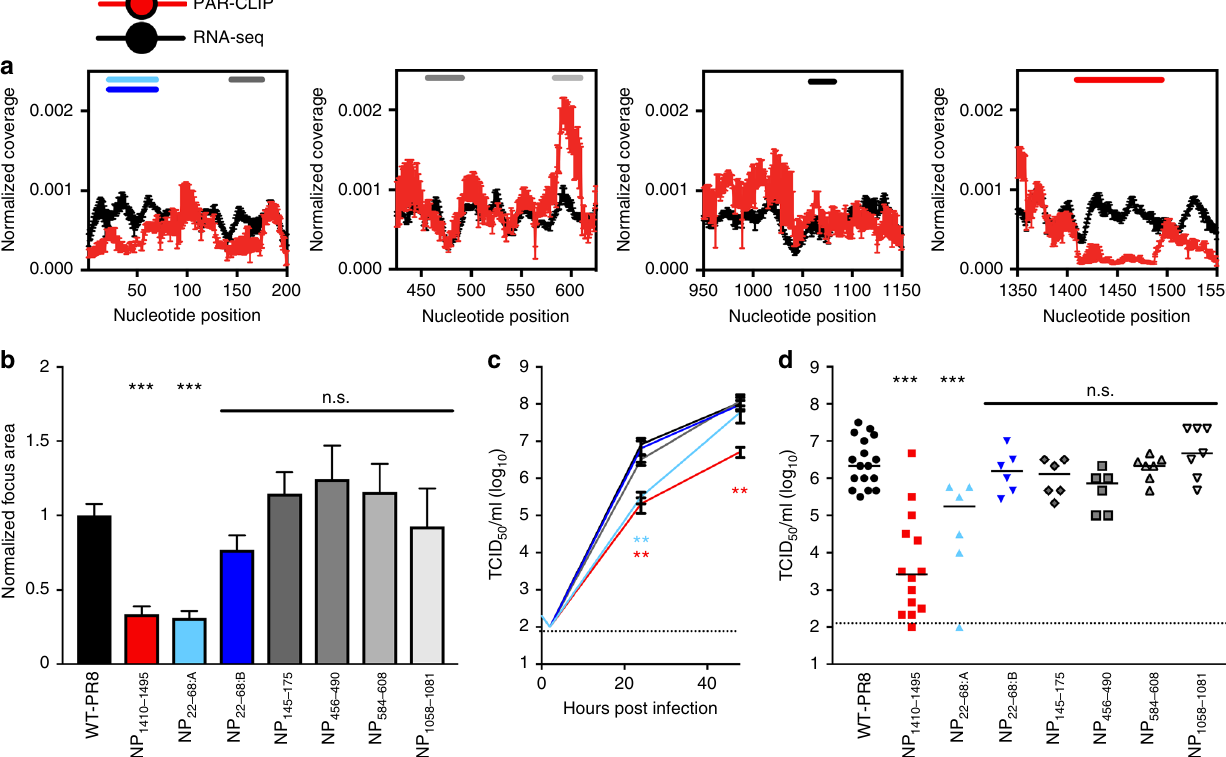
Fig. 2 Manipulation of vRNA in low-NP-binding regions that disrupts predicted RNA structure attenuates virus replication. a Normalized coverage ± s.e.m. was determined for each nucleotide in the PAR-CLIP (red symbols) and RNA-seq (black symbols) libraries ( n = 4 each). Six regions of interest (ROI) in segment 5 (NP) are highlighted, including two low-NP-binding regions (NP 1410 – 1495 and NP 22 – 68 ) and four intermediate NP-binding regions (NP 145 – 175 , NP 456 – 490 , NP 584 – 608 , and NP 1058 – 1081 ). Each ROI is indicated with a colored bar. b Focus area of WT-PR8 and NP mutant IAV. MDCK cells were infected with serial dilutions of the indicated viruses and overlayed with infection media (M0.1B) containing 1% agarose and TPCK-trypsin. Seventy-two hours later cells were fi xed, permeabilized, and stained for viral antigen (NP). Focus diameter was determined and normalized to WT-PR8 per experiment. Results are the average + s.e.m. of 3 – 5 experiments per virus ( > 60 foci each). c MDCK cells were infected with MOI = 0.001 of the indicated viruses and culture supernatant was collected at indicated time points then titered on MDCK cells. Results are the average ± s.e.m. TCID 50 ml − 1 of two experiments performed in duplicate. d C57BL/6J mice were inoculated with 10 3 TCID 50 of the indicated viruses in 30 µ L. Lungs were collected, homogenized, and titered on MDCK cells. Each dot is a single mouse and the line is the median. Dotted line in c , d represents the limit of detection. (*** P < 0.005; ** P < 0.01; n.s. not signi fi cant by one-way ANOVA with multiple comparisons correction (Kruskal – Wallis